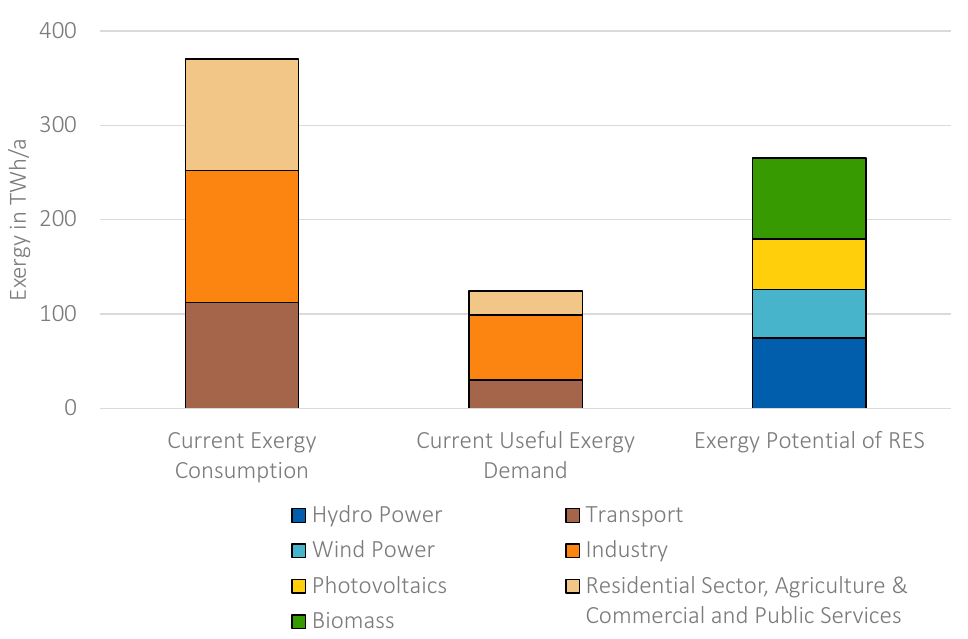
Table 10. Austria-wide comparison of the current exergy consumption and the current useful exergy demand per sector, including the exergetic efficiency. The efficiency is the highest in the industrial sector, since it needs a lot of heat at high temperature levels. Sector